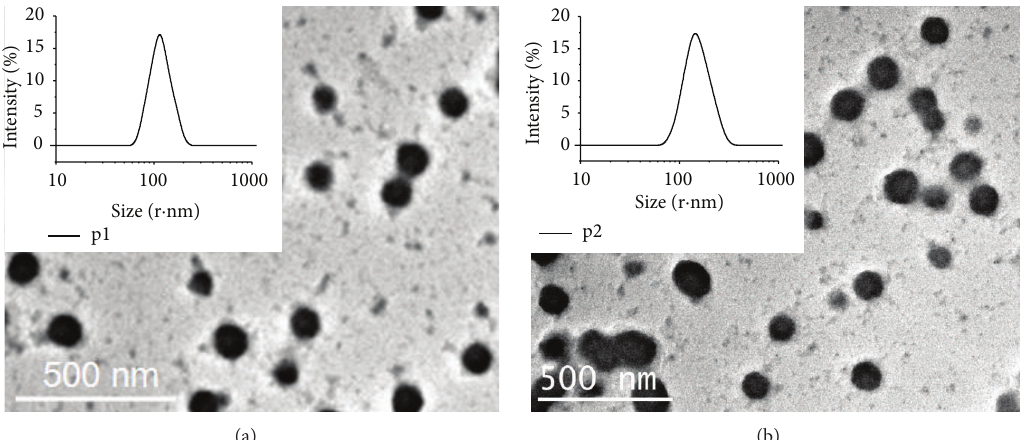
Figure 3: High-resolution TEM micrographs of the self-assemblies of (a) p1 and (b) p2. Insets are corresponding hydrodynamic diameter distributions recorded by DLS. Note. Staining was performed with phosphotungstic acid and the tiny particles may be the crystal of excess phosphotungstic acid.